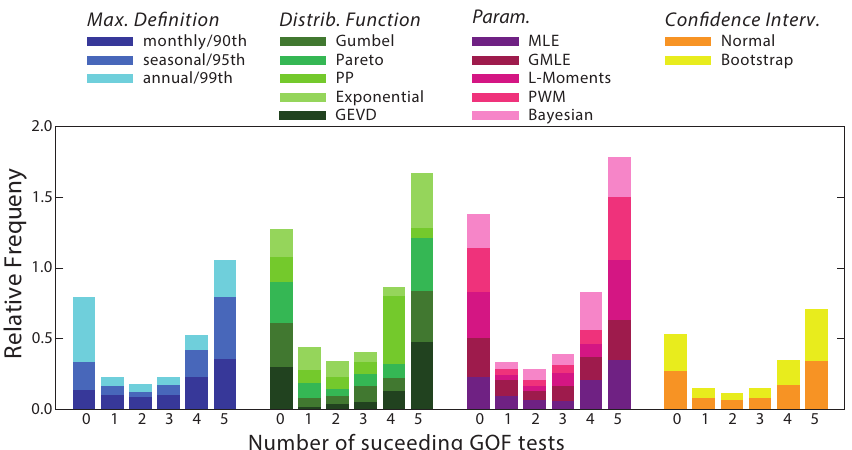
Figure 4. Histograms of successful goodness-of-fit tests segregated according to the various method- ological options (see colors in legend). Max. Def. , indicates the criterion followed to define the wind extremes, depending on whether the corresponding family distribution is Block-Maxima or POT (see Table 1 in Section 3.1); Distrib. Function relates to the family distribution; Param. stems for the parameter estimation method; finally Confidence Interv. indicates the methodology to estimate confidence interval within each individual